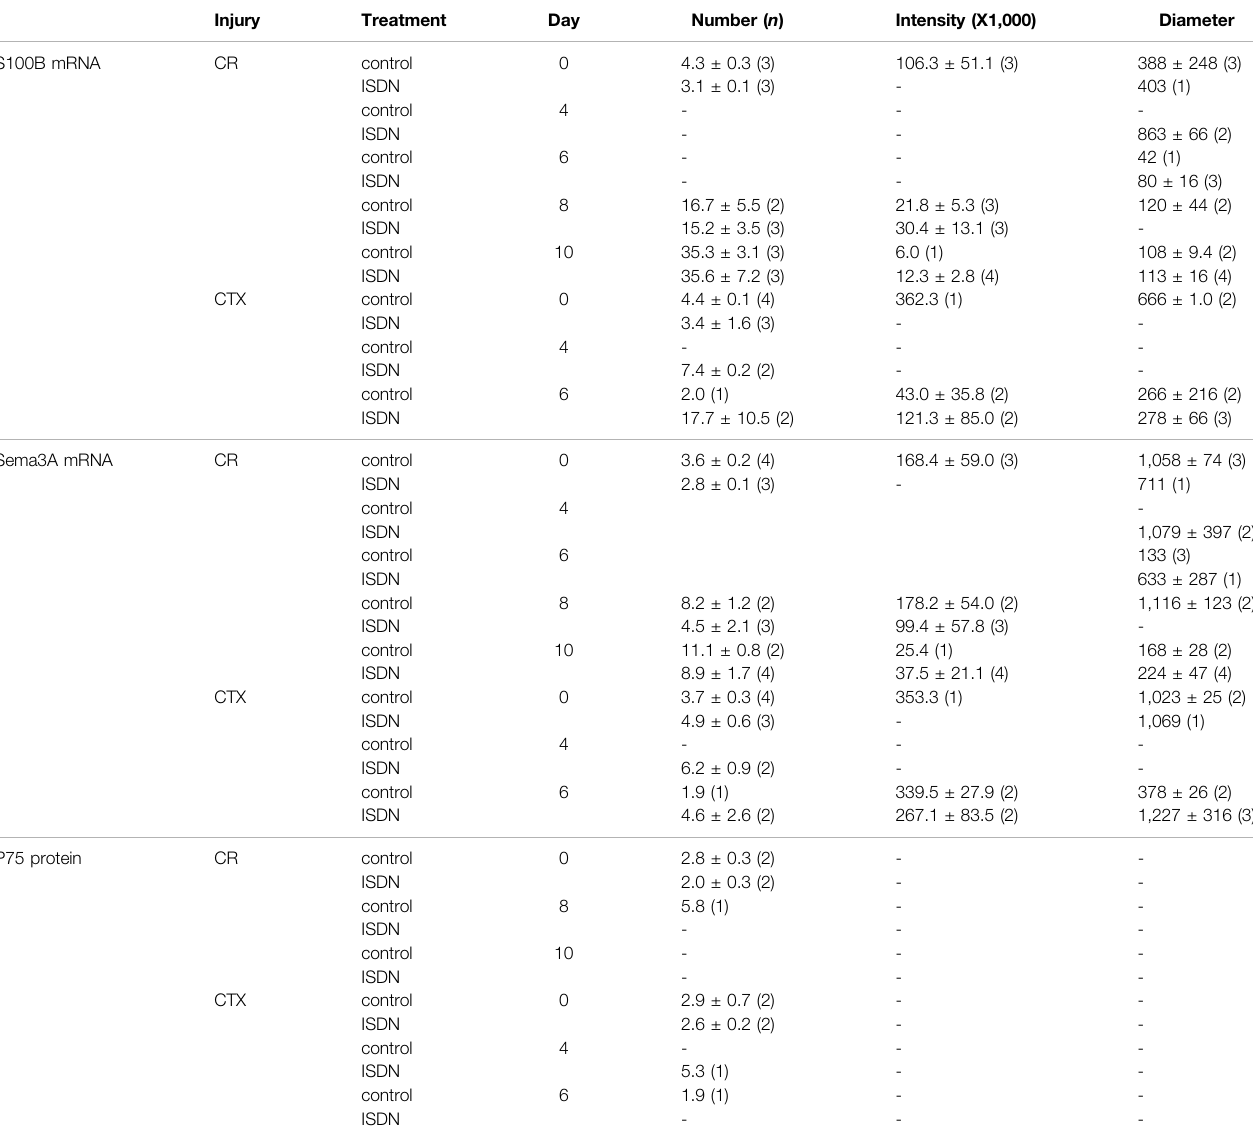
TABLE1| ExpressionanalysisofS100BandSema3AtranscriptsandP75proteininregeneratingmuscle.Muscle-crush(CR)-andcardiotoxin(CTX)-injuredmusclesinmice withouttreatment(control)orafter2daysofpretreatmentwithisosorbidedinitrate(ISDN)from0to10daysafterinjury(Day).Cellestesoftwaremeasuredtheexpression- site number, the intensity of fl uorescence (areal density, arbitrary grayscale units), and the diameter (pixels) against calibration standards. Sample size ( n ) for each entry appears in brackets; “ - ” indicates missing